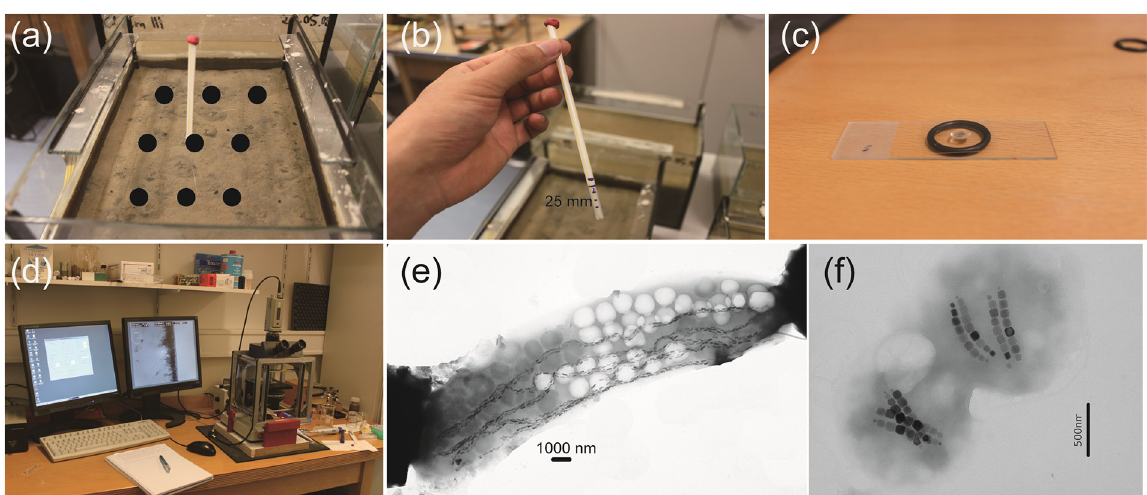
Fig 2. Procedures of sampling and measurements. (a) 6–9 sediment mini-cores were sampled around the 9 areas indicated by the black dots. (b) a mini-core, 25 mm long, was taken by a drinking plastic straw. Each mini-core was sliced every 1 mm increment and diluted with distilled water. (c) A drop of 10 μ l diluted solution was made to be a hanging drop over an O-ring. (d) MTB number was directly obtained under the magnetodrome. (e) Transmission electron micrograph (TEM) image of a rod-shaped M . bavaricum cell with a few bundles of magnetosomes. (f) TEM image of two coccic cells with four bundles of magnetosomes in each